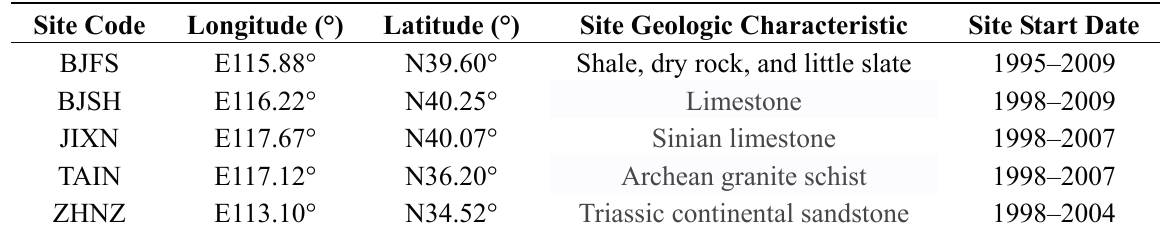
Table 1. Specific information of selected GPS